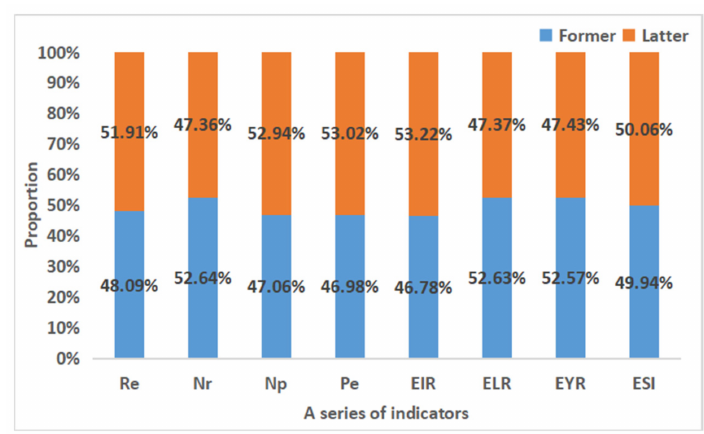
Figure 11. Comparison of former and latter based on 10%